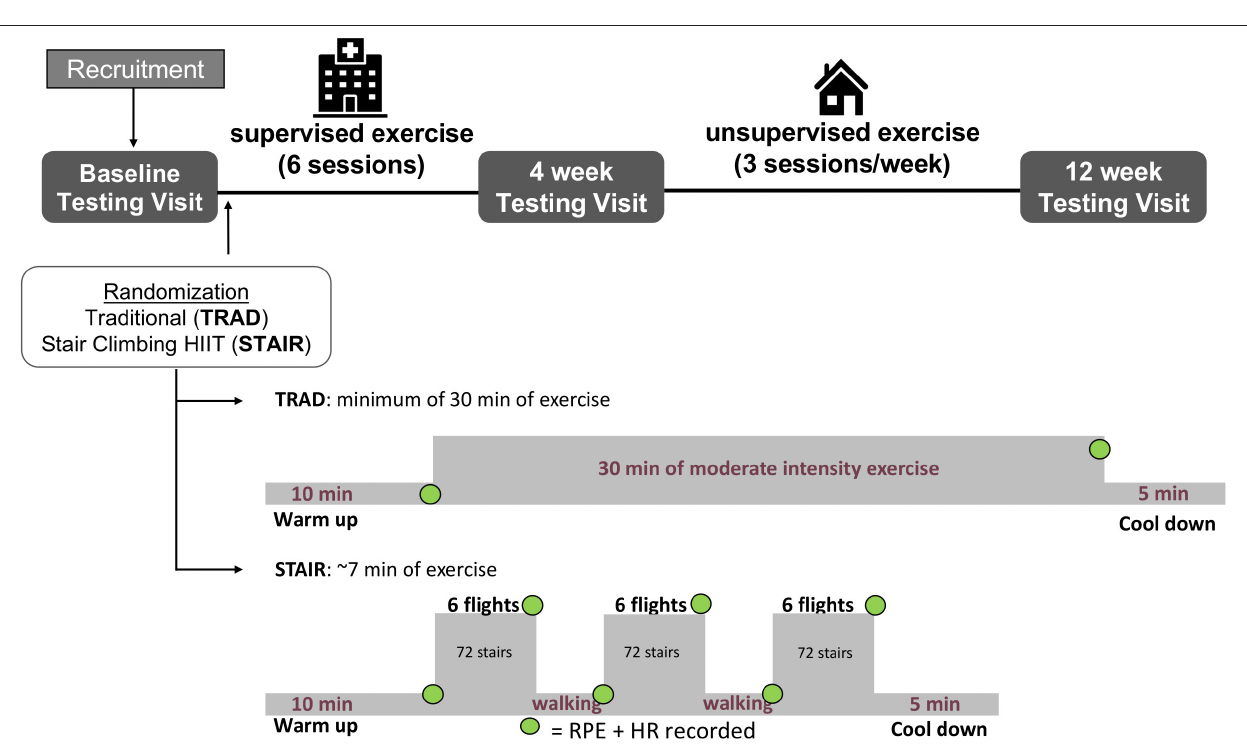
FIGURE 1 | Illustration of the study timeline and exercise interventions. Participants were recruited and completed the baseline testing visit and then were randomized to either the traditional moderate-intensity continuous training (TRAD) or stair climbing high intensity interval training (STAIR) groups. The participants completed six sessions of supervised exercise at the Cardiac Health and Rehabilitation Center (CHRC) and then underwent the second testing visit. Thereafter, the participants completed unsupervised exercise for an additional 8 weeks and then completed the final testing visit. TRAD consisted of a minimum of 30min of moderate intensity exercise at 60–80% peak heart rate. STAIR consisted of three bouts of climbing a single flight of stairs 6 times at a self-selected, but vigorous pace (14–15/20 RPE) separated by a ∼ 90s periods of active recovery at a comfortable pace ( ∼ 7min total of high and low intensity intervals). For both exercise protocols heart rate was monitored continuously throughout the exercise session. Each of the estimated exercise times include the 10min warm-up and 5min cooldown. RPE and HR were recorded on paper at the specific timepoints indicated by a green dot. RPE, rating of perceived exertion; HR, heart rate. The hospital icon was created by Nibras@design, the nounproject.com. All other icons were developed using Microsoft PowerPoint (version 16.45 for